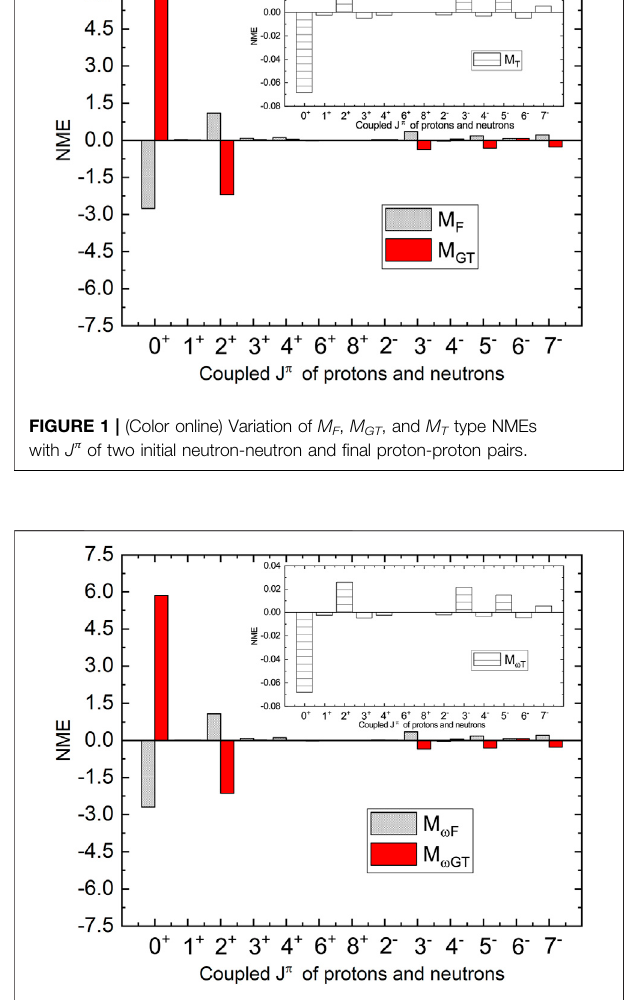
FIGURE 2 | (Color online) Variation of M ω F , M ω GT , and M ω T type NMEs with J π of two initial neutron-neutron and fi nal proton-proton